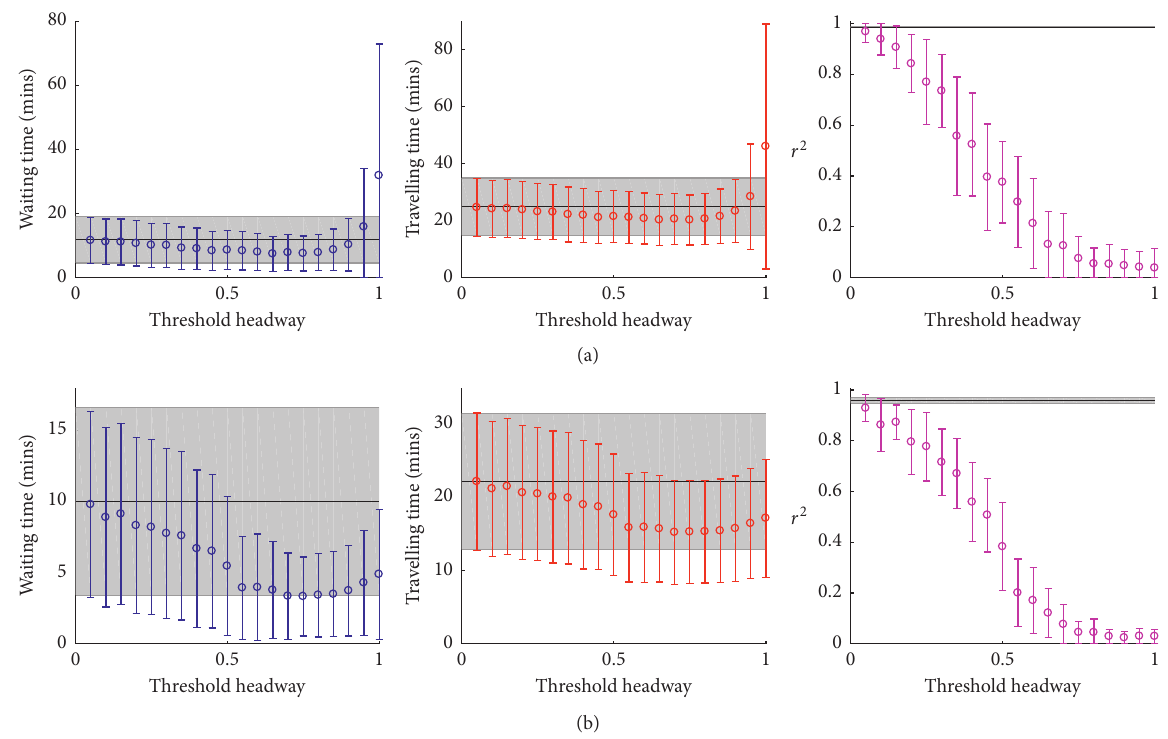
Figure 8: Results of the distance-based no-boarding strategy on the two same-velocity scenarios. Each colored point represents the mean and standard deviation of the measured quantities calculated from 100 realizations of each parameter value. The black line and grey shaded area of each graph denote the mean and standard deviation of the measured quantities from a control case, which are simulation runs of the same parameter values, without any intervention strategies. (a) Distance-based no-boarding strategy in lull-same. (b) Distance-based no- boarding strategy in